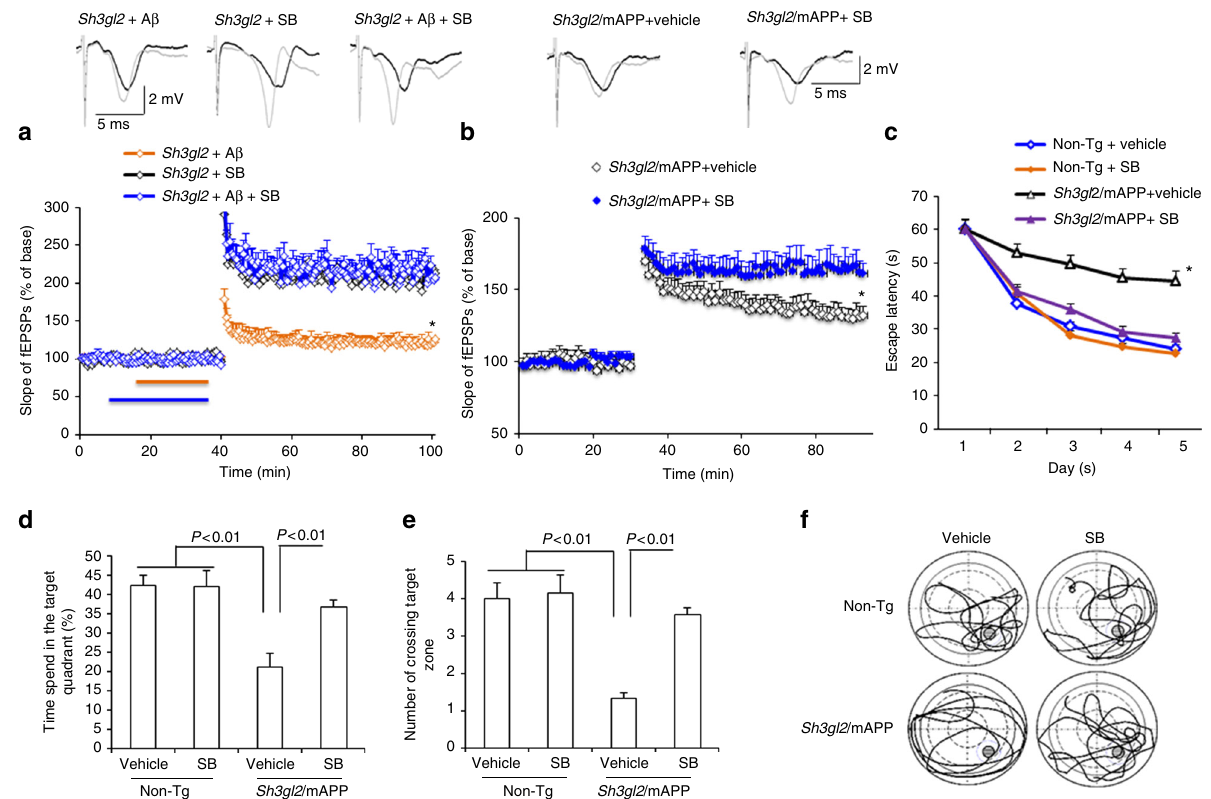
Fig. 8 Inhibition of p38 MAP kinase rescues impairment on synaptic plasticity and spatial learning and memory in Tg Sh3gl2 /mAPP mice. a , b Hippocampal slices from 5-month-old to 6-month-old Tg Sh3gl2 mice were pretreated with SB203580 (SB, 1 µ M) for 5 min before A β perfusion (100 nM for 20 min) and then hippocampal CA3-CA1 LTP was recorded ( a ). Tg Sh3gl2 /mAPP mice were intraperitoneally injected with SB203580 (0.5 mg/kg) once a day for 3 weeks and then performed LTP experiments ( b ) and Morris water maze test ( c – f ) at the age of 5 – 5.5 months. Upper panels of a and b show representative traces of fEPSP in the indicated slices with the indicated treatment before θ -burst stimulation (black line) after 1 h (gray line). Administration of SB203850 signi fi cantly ameliorated hippocampal LTP de fi cit in Tg Sh3gl2 /mAPP mice compared to the vehicle-treated group. Error bars represent s.e. m., n = 7 – 10 per group. * p < 0.01 (one-way ANOVA in a , b ). c Escape latencies in hidden platform during Morris water maze task training in indicated groups. Error bars represent s.e.m., n = 8 – 9 mice per group (one-way ANOVA). d Time spent in the quadrant with the hidden platform and e mean